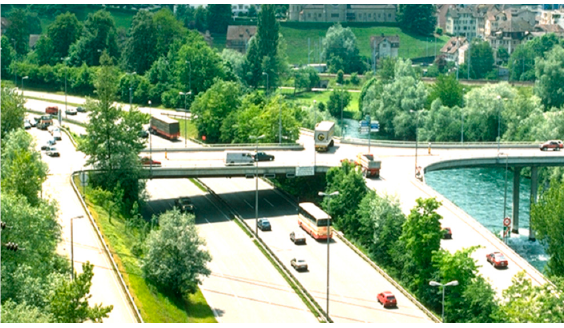
Figure 8. The Ibach Bridge near Lucerne, Switzerland.